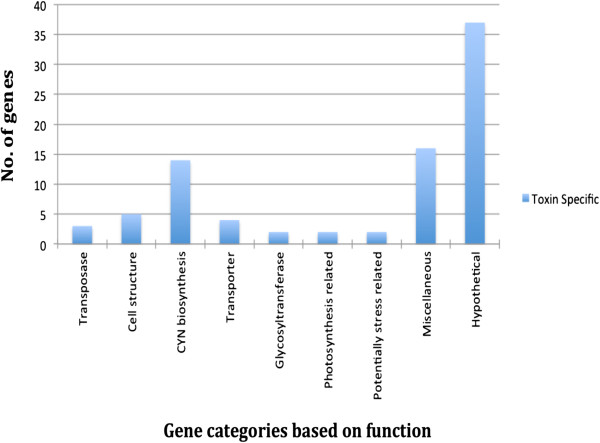
Classification of toxic strain (CS-505 and CS-506)-specific genes. The miscellaneous category represents genes responsible for protein processing, sialic acid metabolism and cell division.